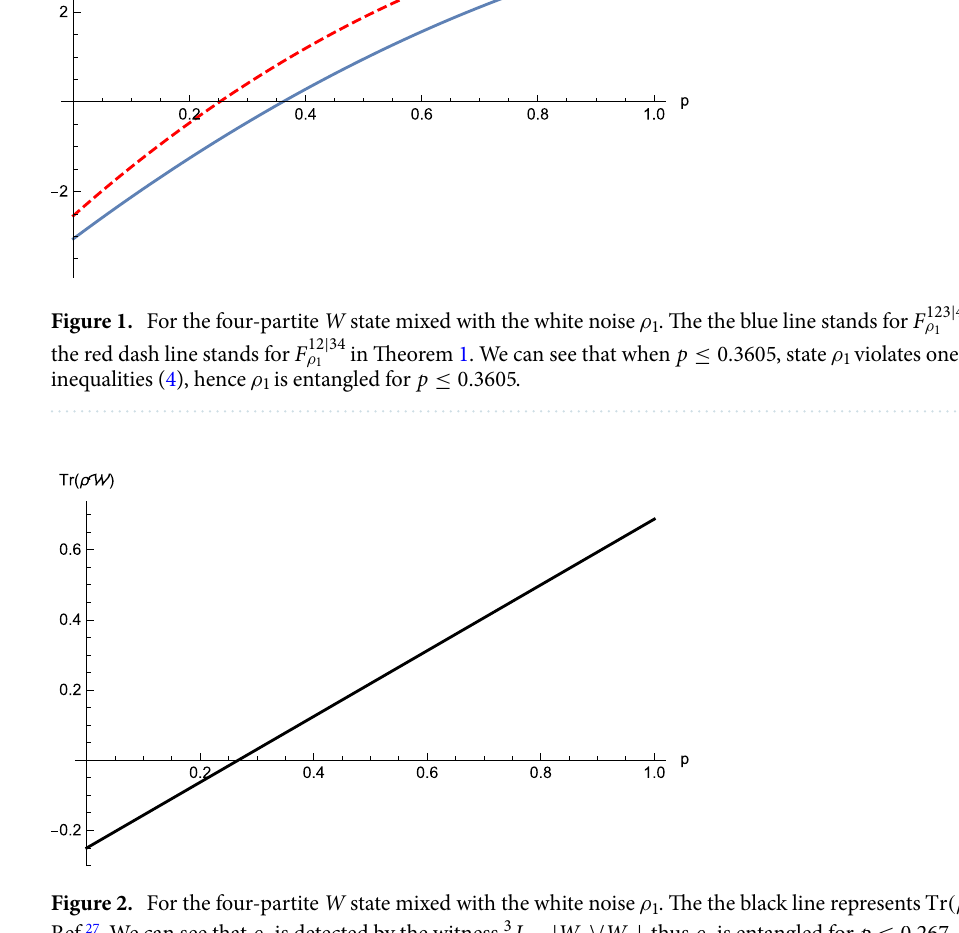
W 4 W 4 , thus ρ 1 is entangled for p − | �� |